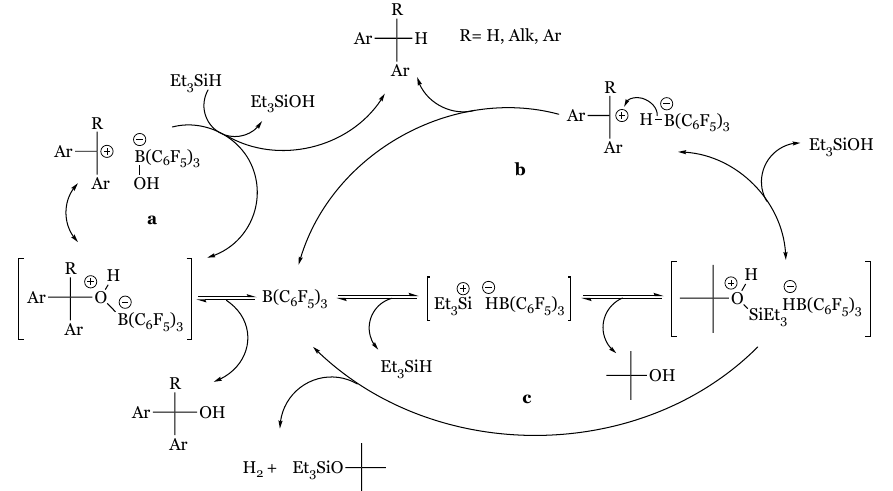
Figure 46. Suggested S N 1 pathways for alcohols with: ( a ) and ( b ) carbocation-supporting aryl substituents; ( c ) dehydro-condensation to silyl ether for less-stabilized alcohols.